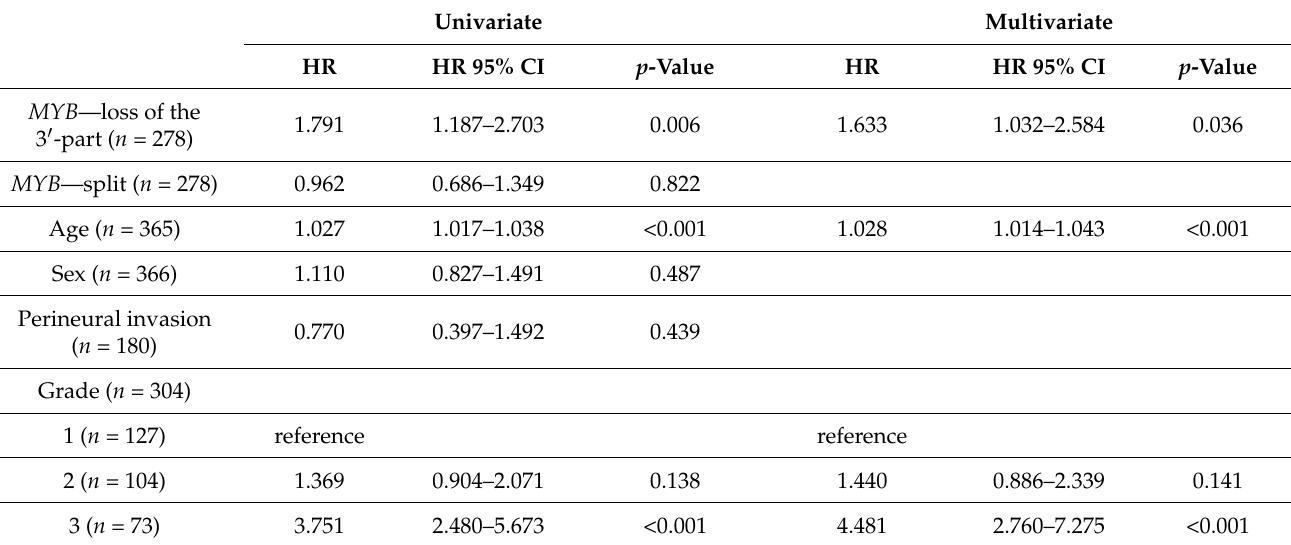
Table 1. Univariate and multivariate ( n = 224) analyses of the hazard function of death in ACC patients. Univariate Multivariate HR HR 95% CI p